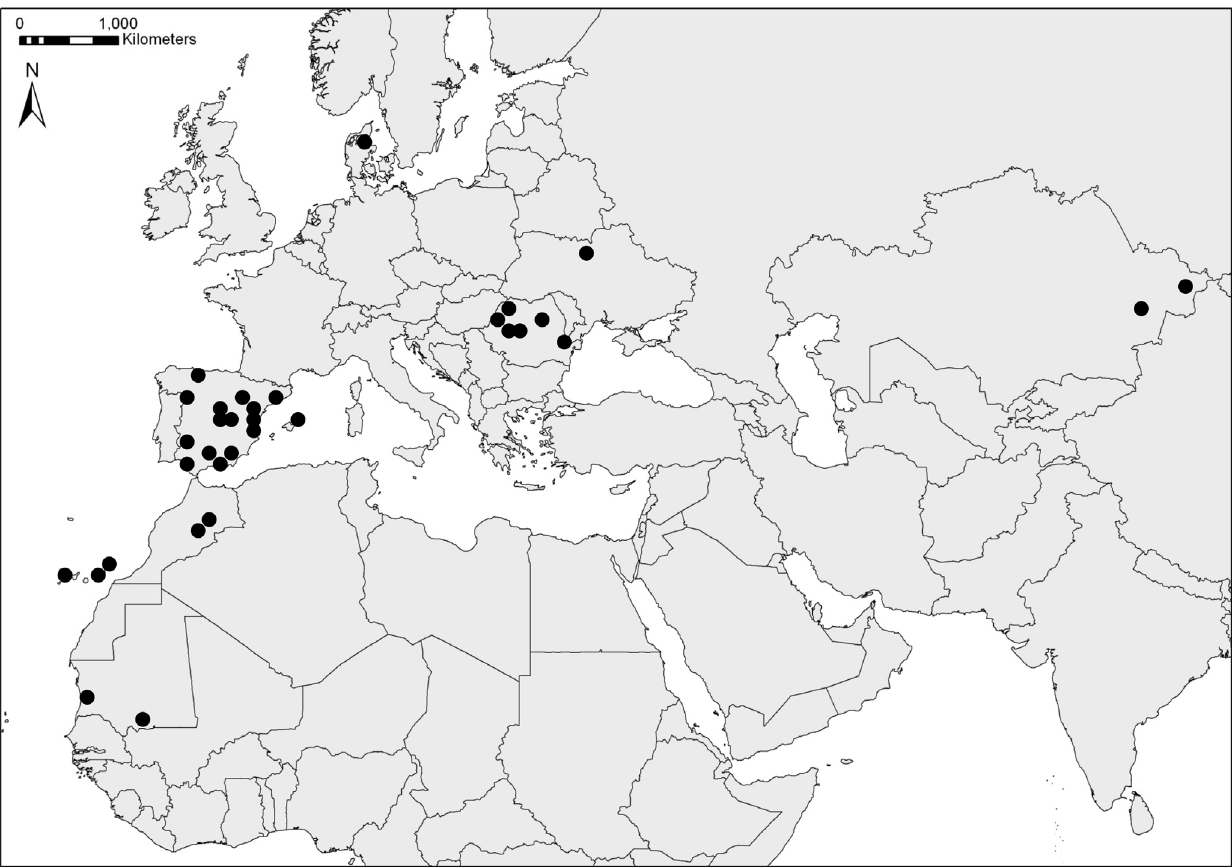
Figure 1. Study area and spatial distribution of data. Close sampling points are summarised by black circles. Countries (sampled bird individuals): Mauritania (85), Morocco (105), Spain (70,321), Denmark (2,394), Romania (1,827), Ukraine (1,175) and Kazakhstan (37).